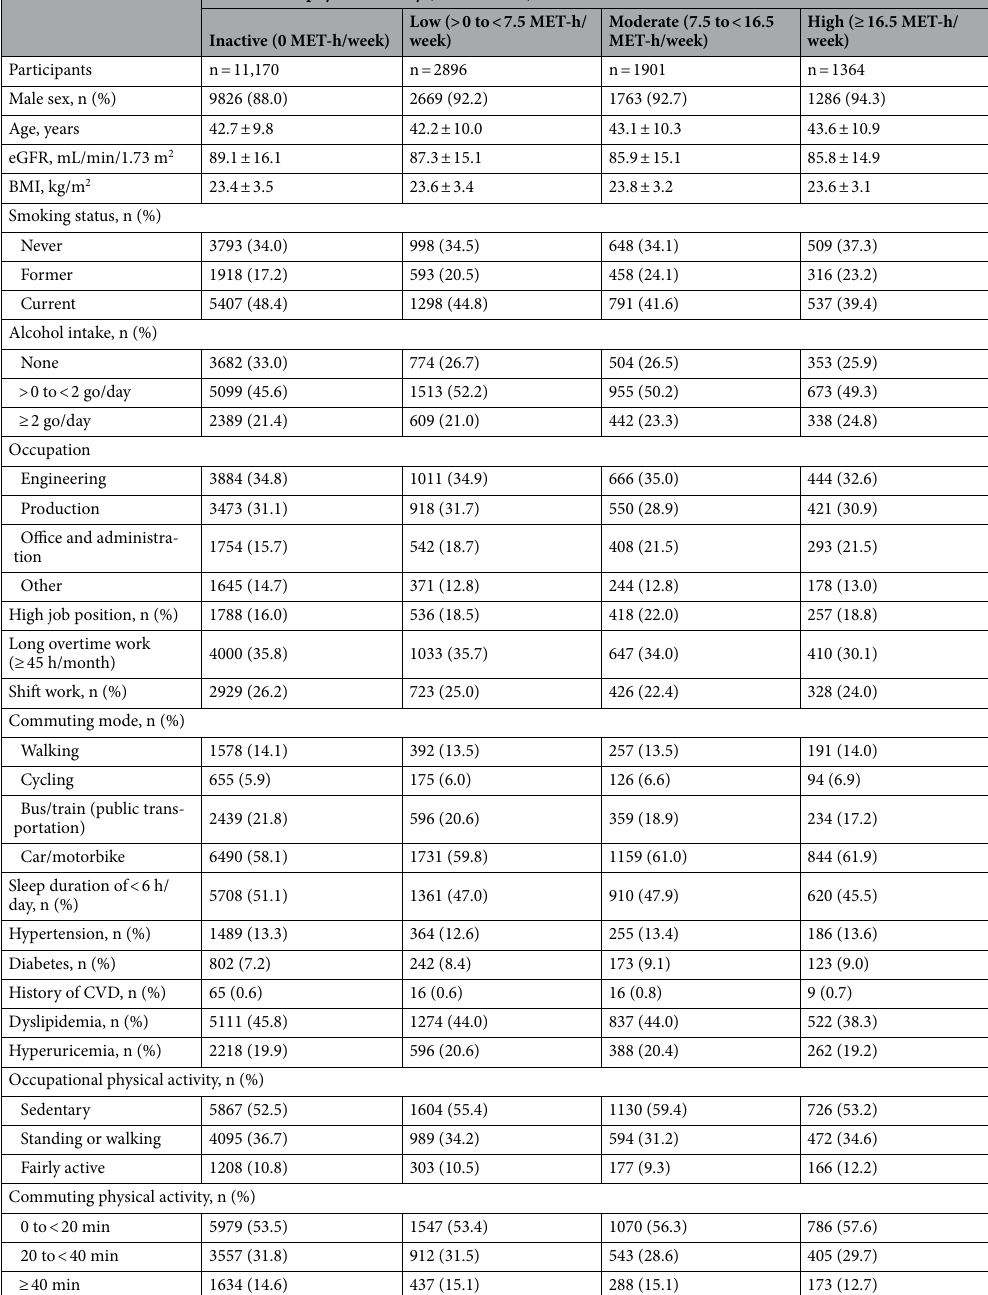
Table 1. Baseline characteristics of the participants, according to the volume of leisure-time physical activity. Data are shown as the mean ± standard deviation for continuous variables and as a number (percentages) for categorical variables. The proportion of missing data for each covariate was as follows: smoking status (0.4%), occupation (3.1%), job position (3.3%), monthly overtime work (3.6%), shiftwork (2.9%), primary